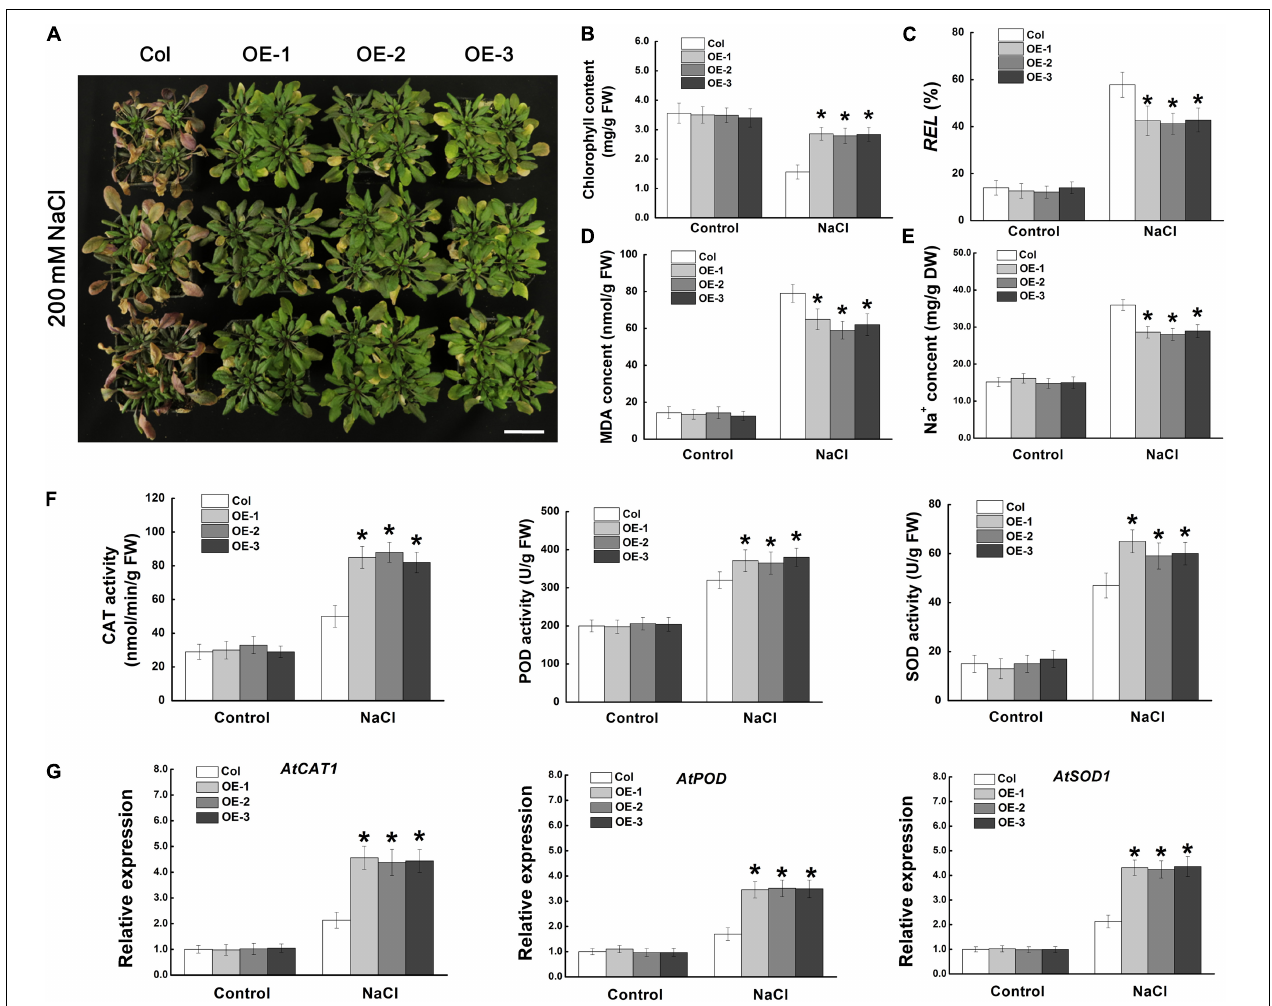
FIGURE 6 | Assessment of salt tolerance in “Col” and MdCCX1 -overexpressing transgenic Arabidopsis plants. (A) Representative images of “Col” and transgenic plants exposed to 200 mM NaCl for 15 d. Scale bars, 4 cm. Total chlorophyll content (B) , relative electrolyte leakage (C) , MDA content (D) , and Na + content (E) of all seedlings lines measured after NaCl treatment. (F) Enzymatic activity of antioxidant enzymes CAT, POD, and SOD measured after NaCl treatment. (G) The relative expression levels of AtCAT1 , AtPOD , and AtSOD1 . AtActin served as a reference gene. Error bars represent SD based on 3 independent replicates. For (B–G) , bars labeled with * in each panel indicates values that are significantly different from “Col” at p < 0.05, using Student’s t-test